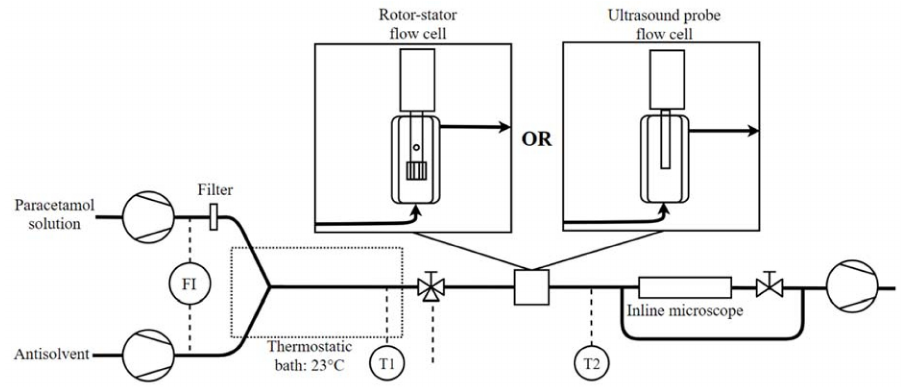
Figure 1. Schematic of the experimental set-up. Mixing inside the flow cell was either done with a 30-kHz ultrasound probe or a rotor–stator mixer.